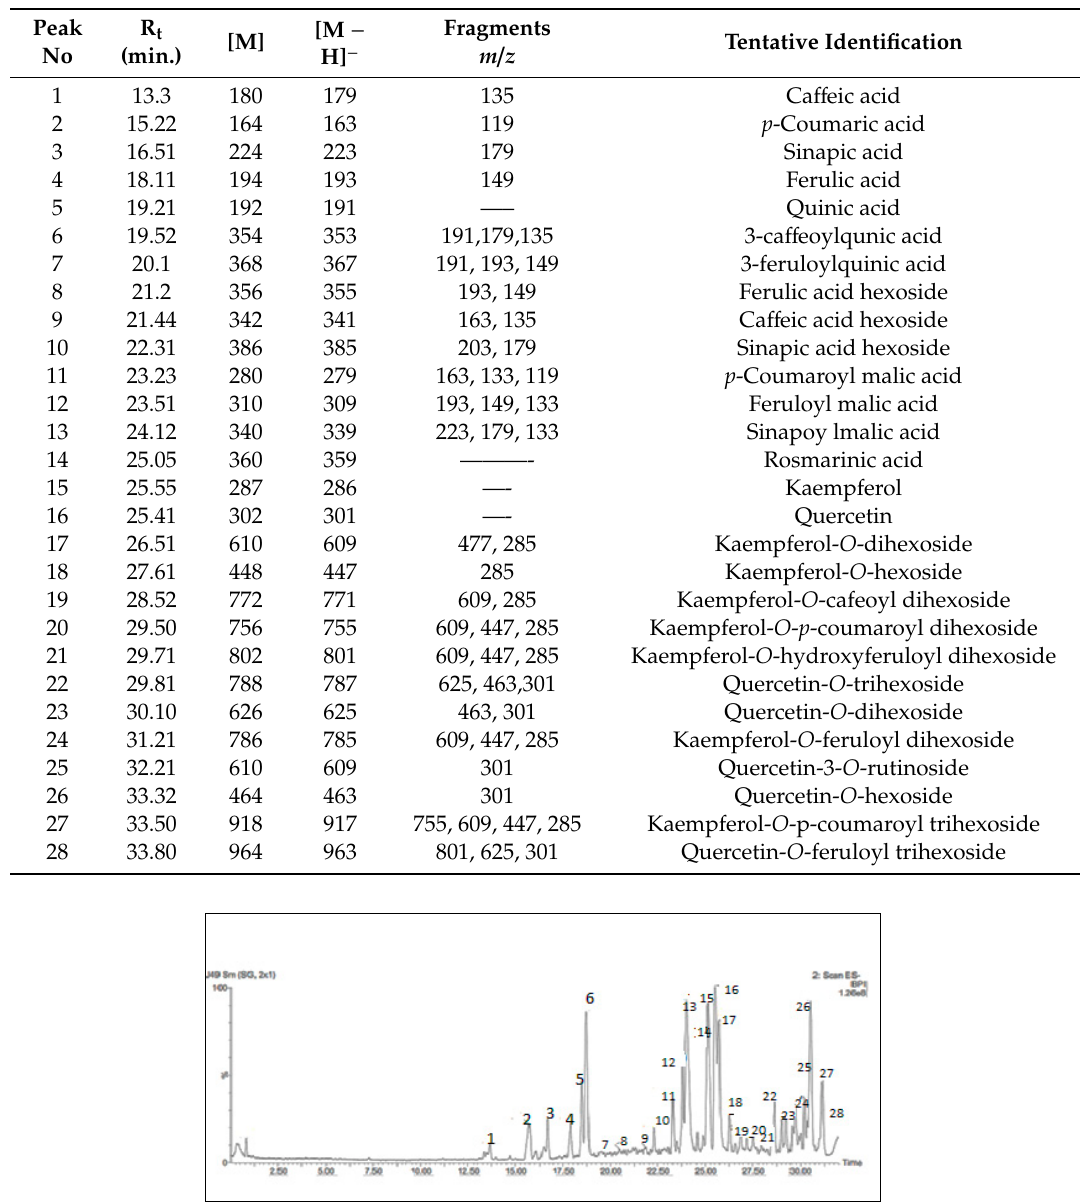
Table 1. LC–MS analysis of ethanolic Brassica juncea L. (mustard) extract.